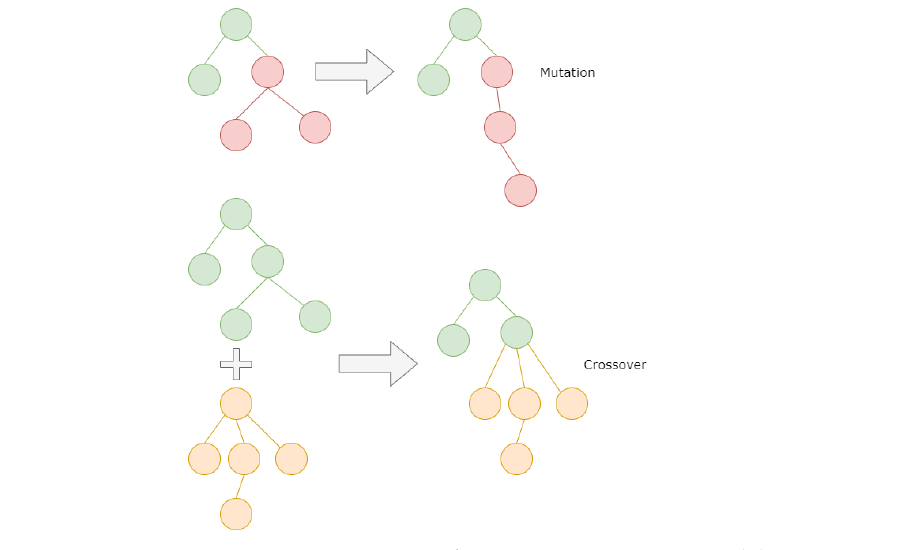
Figure 8. Representation of a genetic programming model.